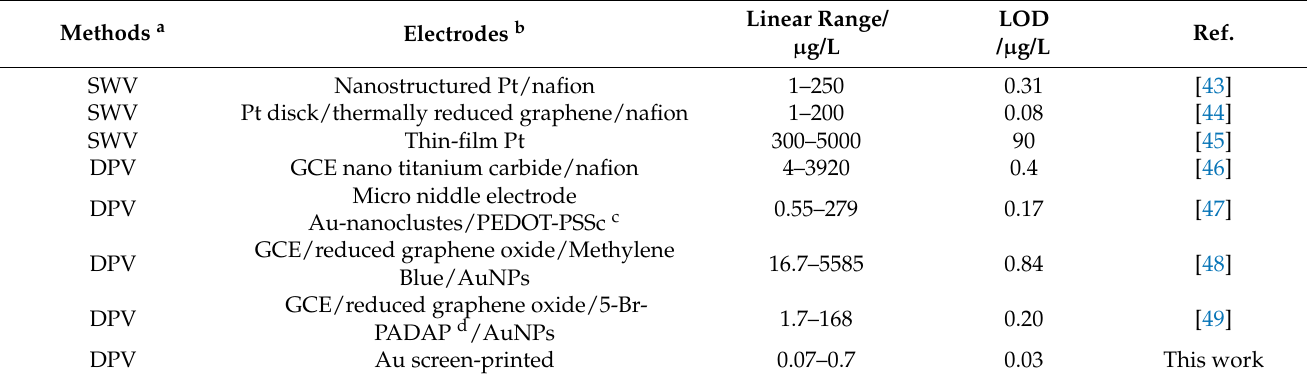
Table 2. Comparison with some recent electrochemical methods.